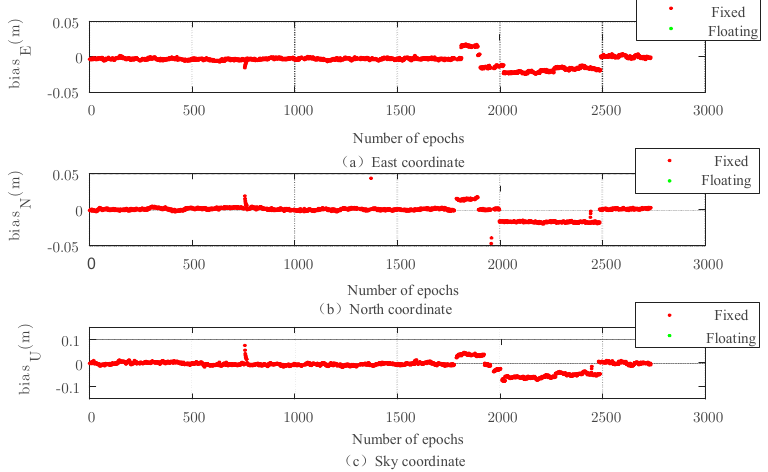
Figure 10. Three − dimensional baseline solution results based on the New-Breadth-First search algorithm.